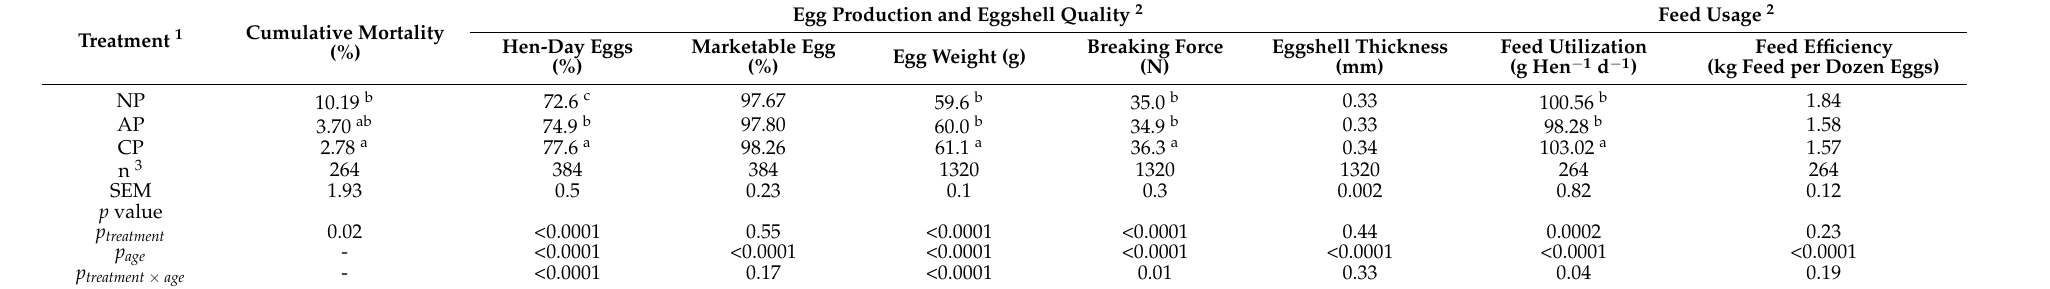
Table 1. The effects of cooled perches on hen mortality, production performance, and egg quality from 17 to 80 weeks of